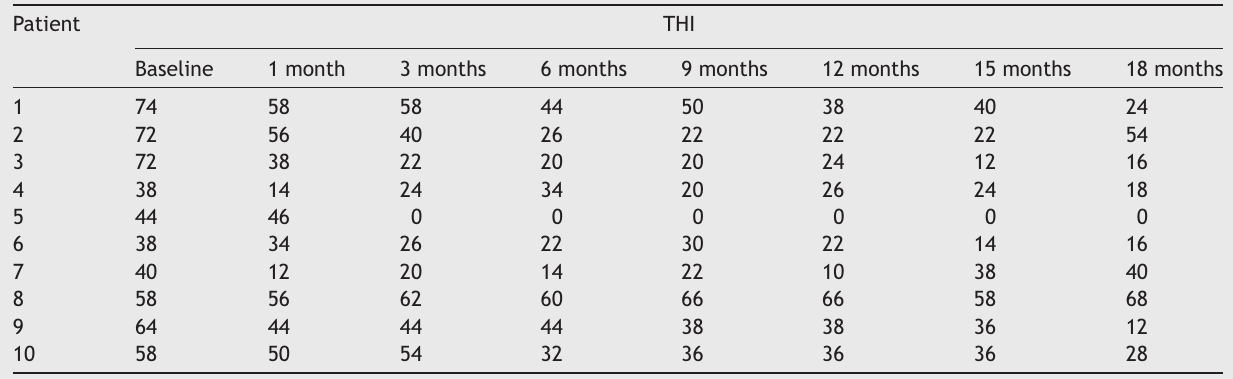
Tinnitus Handicap Inventory (THI) scores during sound